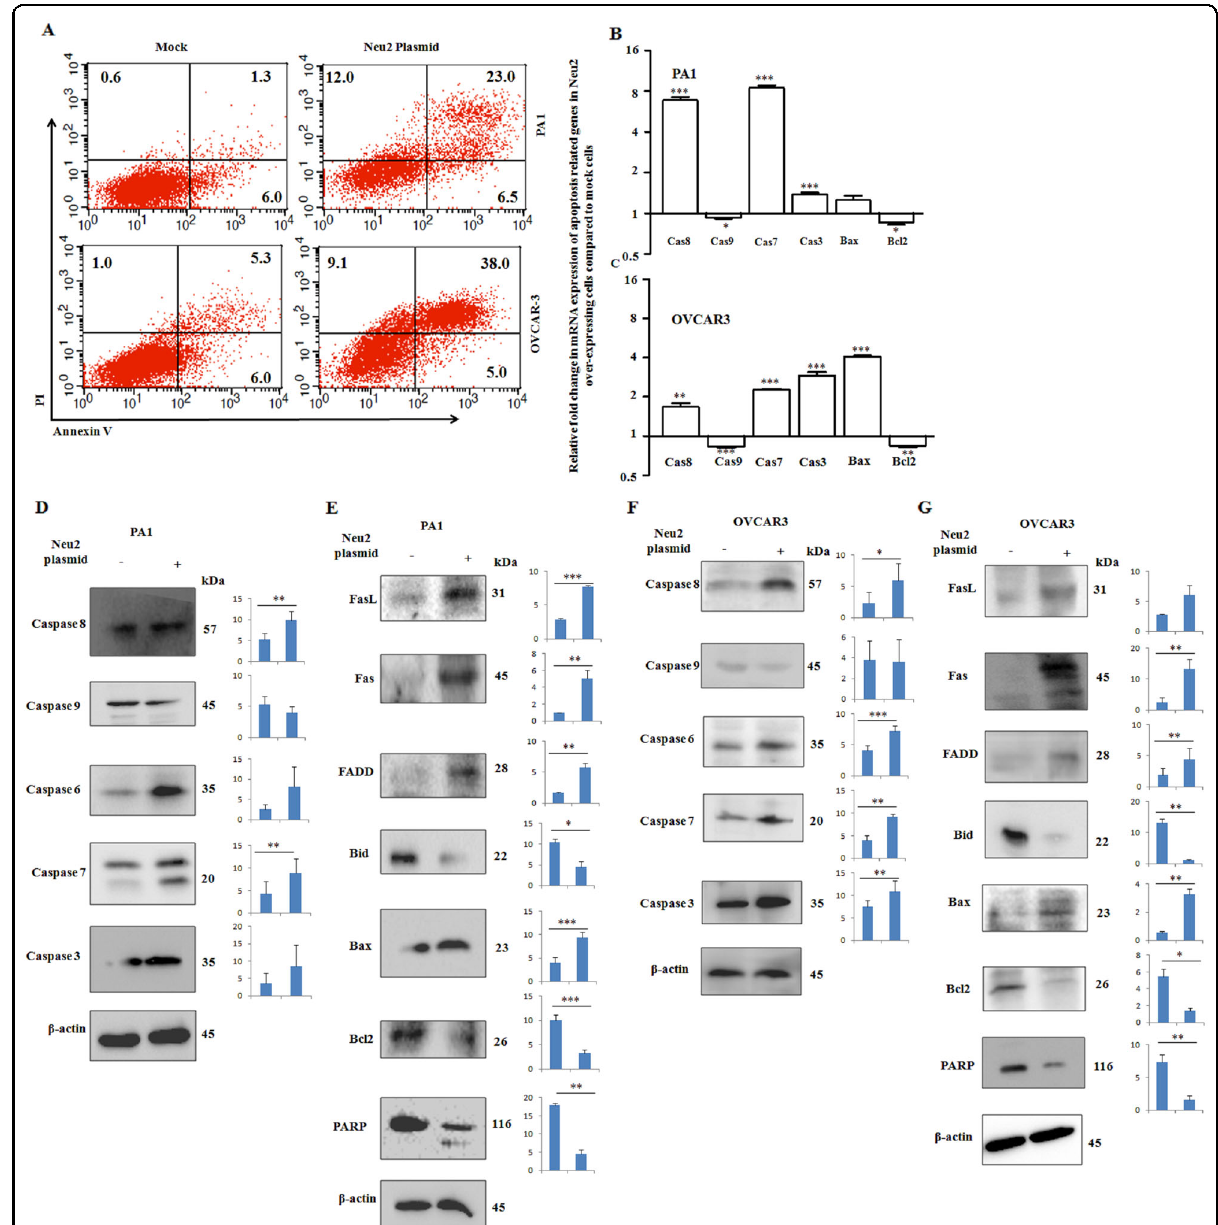
Fig. 4 Neu2 transfection induced apoptosis in ovarian cancer cells. A Neu2-transfected PA1 and OVCAR3 cells were stained with Annexin-V/PI and analyzed by FACS and their apoptotic cell percent are presented and compared with mock. B , C mRNA levels of apoptosis-related molecules were analyzed by real-time PCR in Neu2-transfected PA1 and OVCAR3 cells compared to mock. D – G Western blot analysis showing the protein levels of apoptosis-related molecules in PA1 ( D , E ) and OVCAR3 ( F , G ) cells in mock and Neu2-transfected cells. β -Actin was used as a loading control. The results are represented as mean ± SD from independent experiments and p values (* p < 0.05; ** p < 0.01; *** p < 0.001; two-tailed t test) represented the signi fi cant differences between the means of the two test